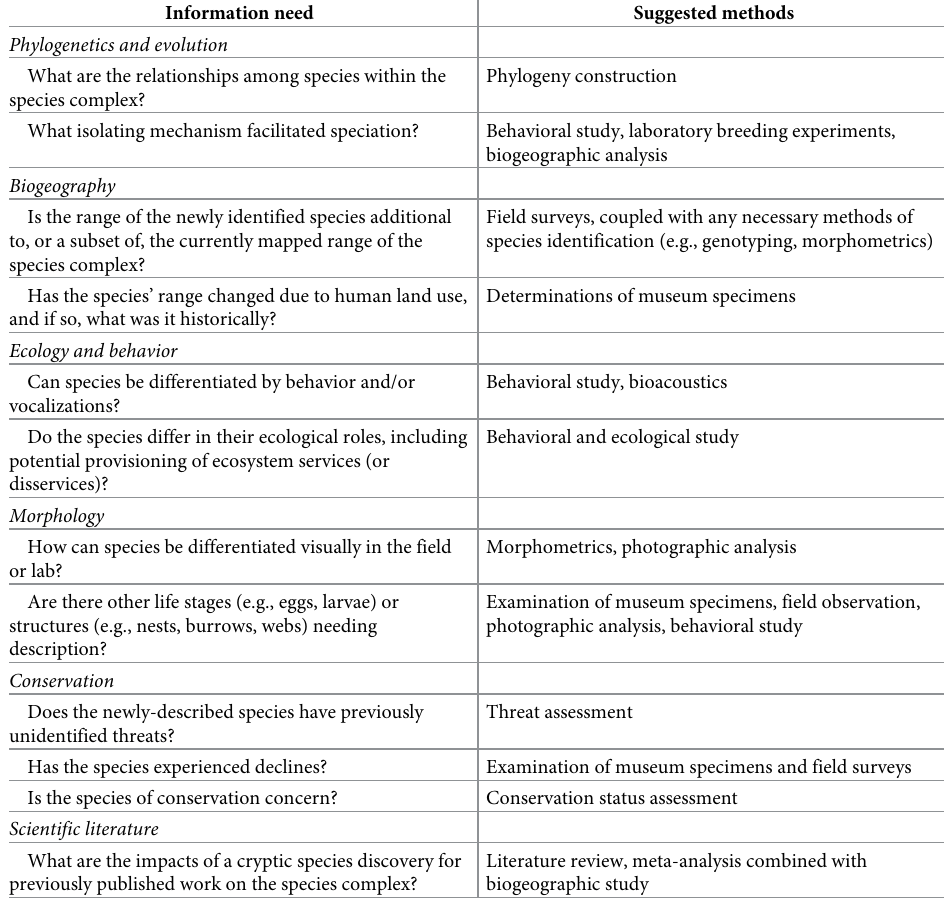
Table 3. Research agenda for follow-up studies on a cryptic species discovery, specifically for cases in which one species is split off from another, presumably through genetic